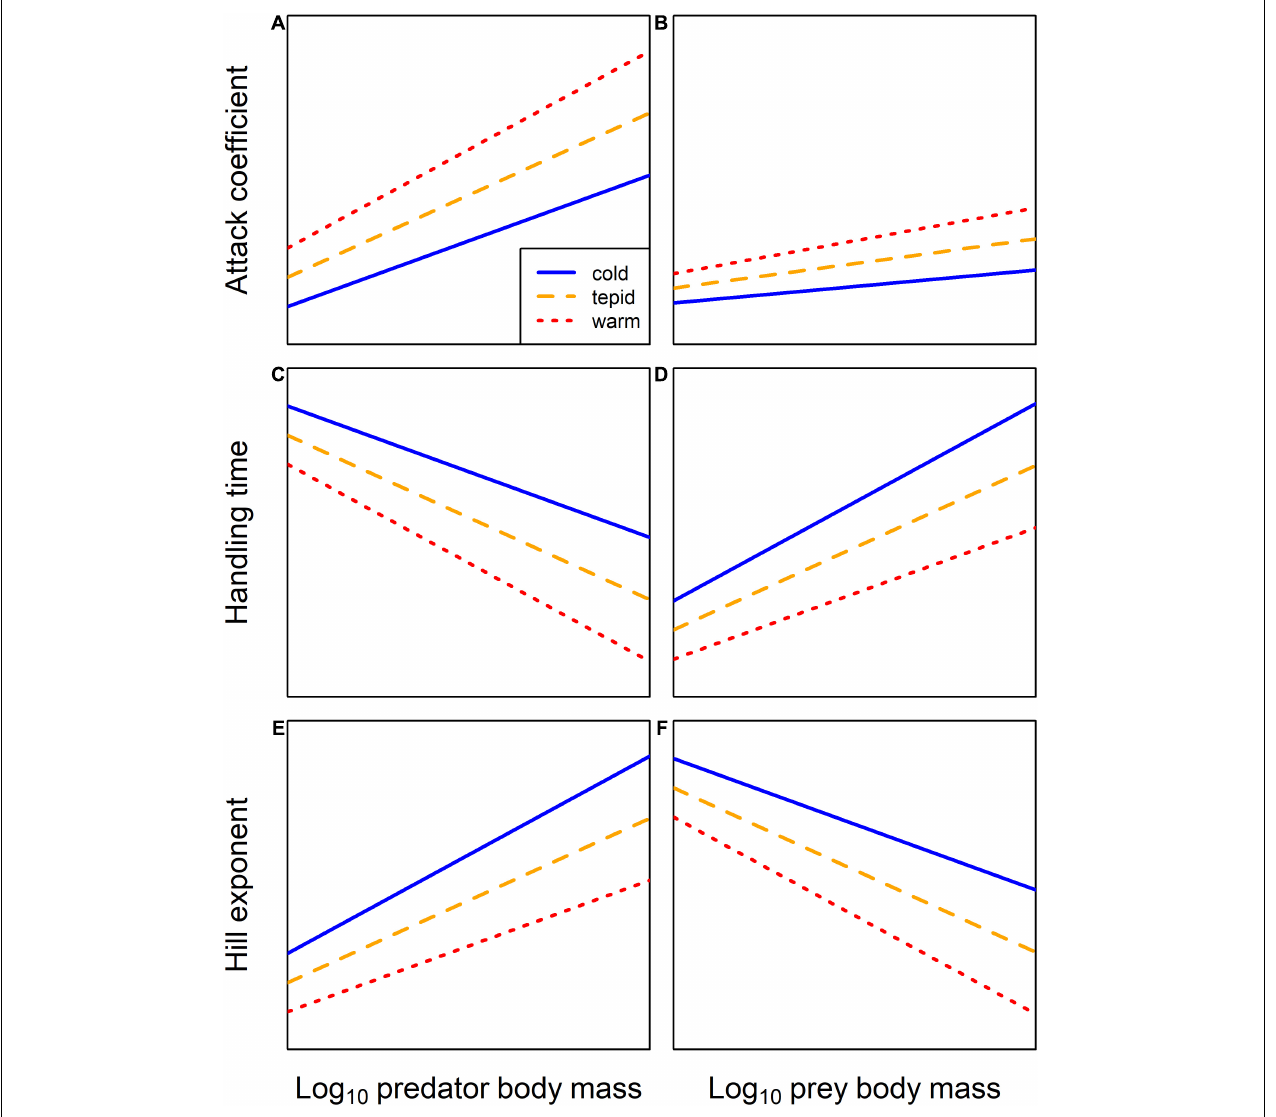
FIGURE 1 | Conceptual illustration of the predicted independent effects of warming and predator or prey body mass on functional response parameters. (A,B) The attack coefficient is predicted to increase with predator body mass, with a much weaker increase for prey body mass, while the intercepts and slopes of these relationships are expected to increase with warming. (C,D) Handling time is predicted to decrease with predator body mass and increase with prey body mass, while the intercepts and slopes of these relationships are expected to decrease and increase with warming, respectively. (E,F) The Hill exponent is predicted to increase with predator body mass and decrease with prey body mass, while the intercepts and slopes of these relationships are expected to decrease with